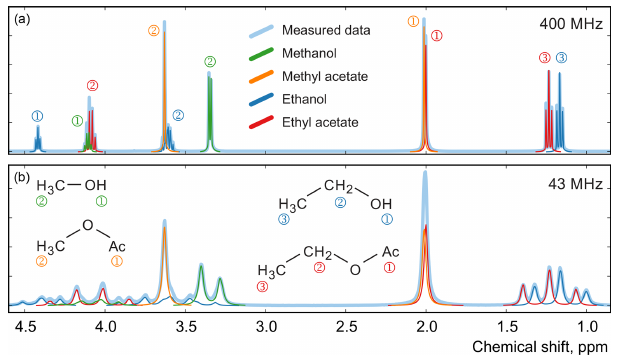
Figure 12. Examples of spectra of a mixture of four organic com- pounds acquired on high-field (a) and medium-field (b) spectrom- eters. In this sample, the mole fractions of all four components are approximately equal. Numbers next to the peaks indicate their as- signment to specific 1 H atoms in the studied